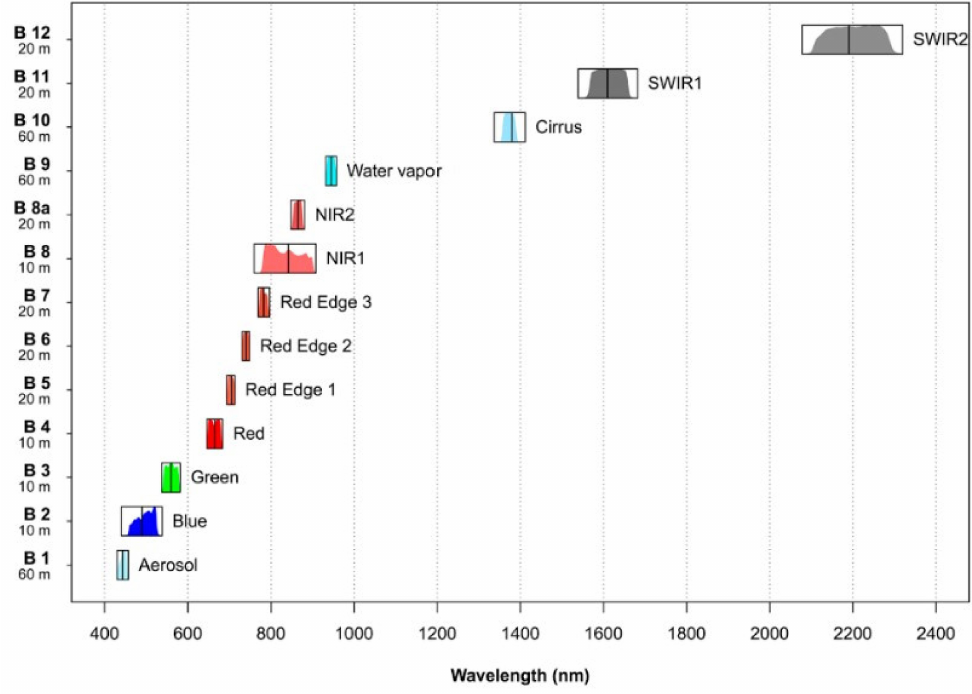
Figure 3. Characteristics of the multispectral instrument (MSI) on board Sentinel-2. Source: [15].